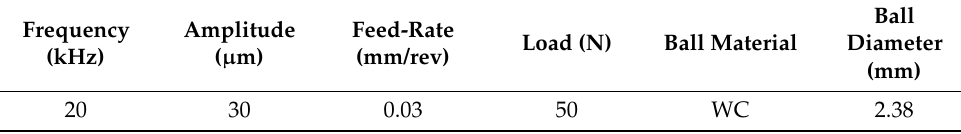
Figure 2. Schematic view of a UNSM treatment. Table 2. Main parameters of UNSM